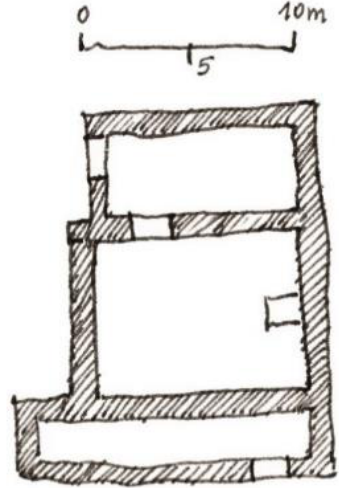
Figure 16. Vienna, the first synagogue phase, ca. 1250. Sketch: Anja Premk.